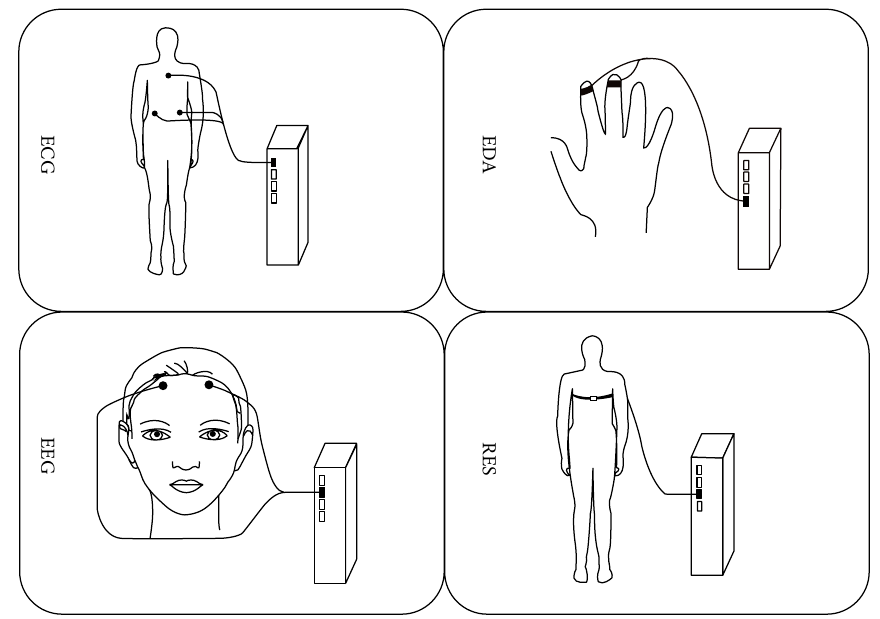
Figure 5: Testing position of physiologic